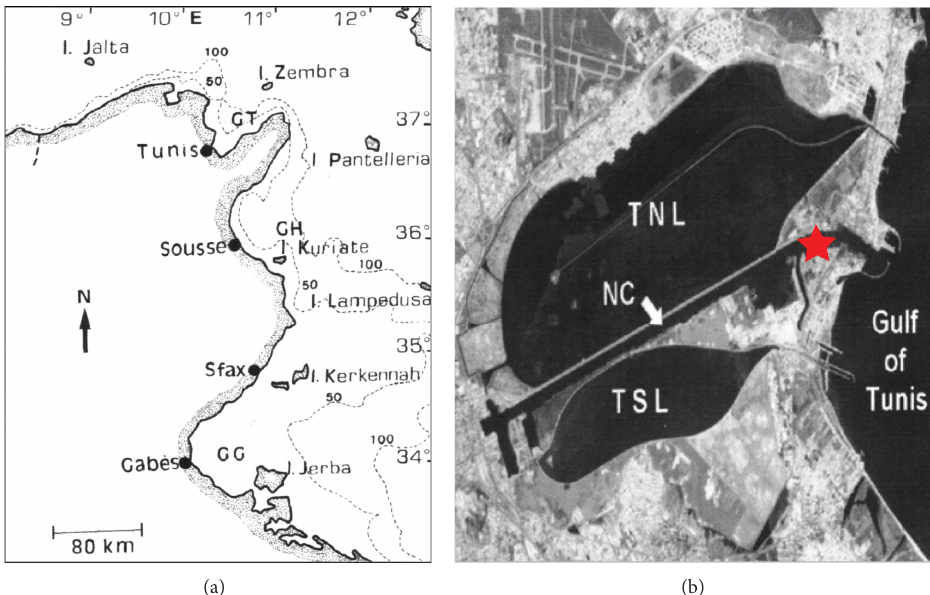
Figure 1: (a) Map of Tunisia with the Gulf of Tunis (GT), the Gulf of Hammamet (GH), and the Gulf of Gabes (GB); (b) Map of Tunis Lagoon divided by channel navigation (NC) in two areas, Tunis Northern Lagoon (TNL) and Tunis Southern Lagoon (TSL), and location of the sampling site inside the navigation channel.